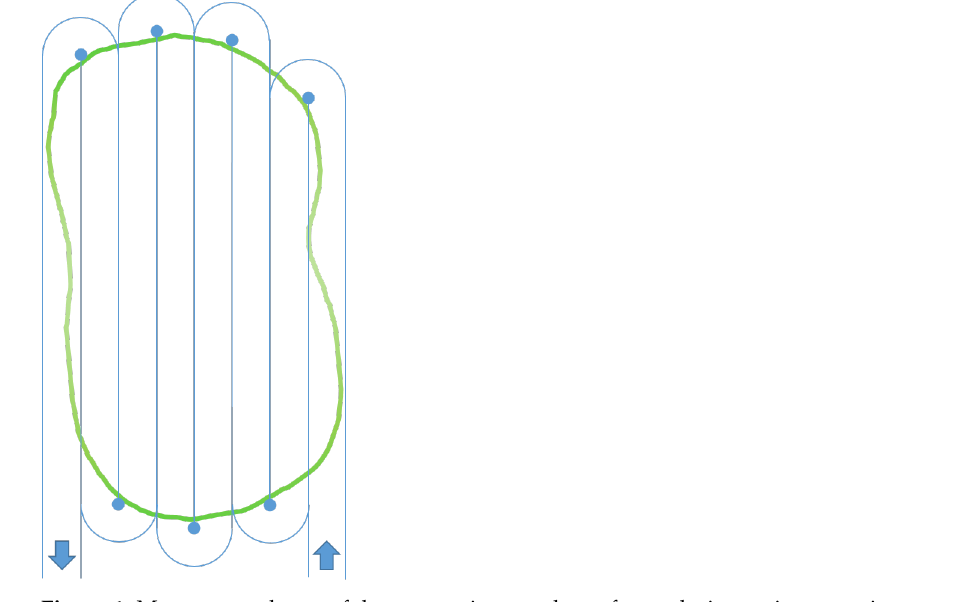
Figure 1. Movement scheme of the reconnaissance drone for exploring a given terrain.